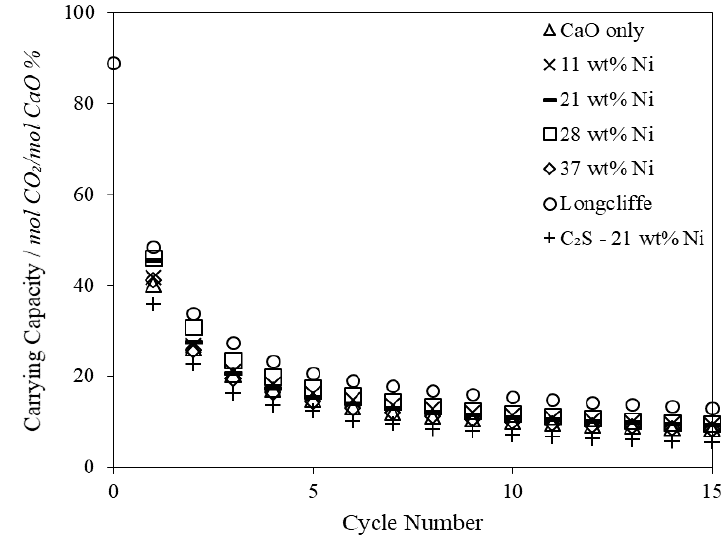
Figure 4. CO 2 carrying capacity in moles of CO 2 absorbed per mole of CaO as a percentage for combined particles of various compositions (300–500 µm). Carbonation at 650 °C for 5 min under 15 vol % CO 2 (balanced N 2 ) and calcination at 950 °C for 1 min under 100 vol % CO 2 . The CO 2 concentration was increased proportionally to the sample temperature to prevent unintended over- carbonation or pre-calcination when the temperature was increased from the carbonation to the calcination temperature.